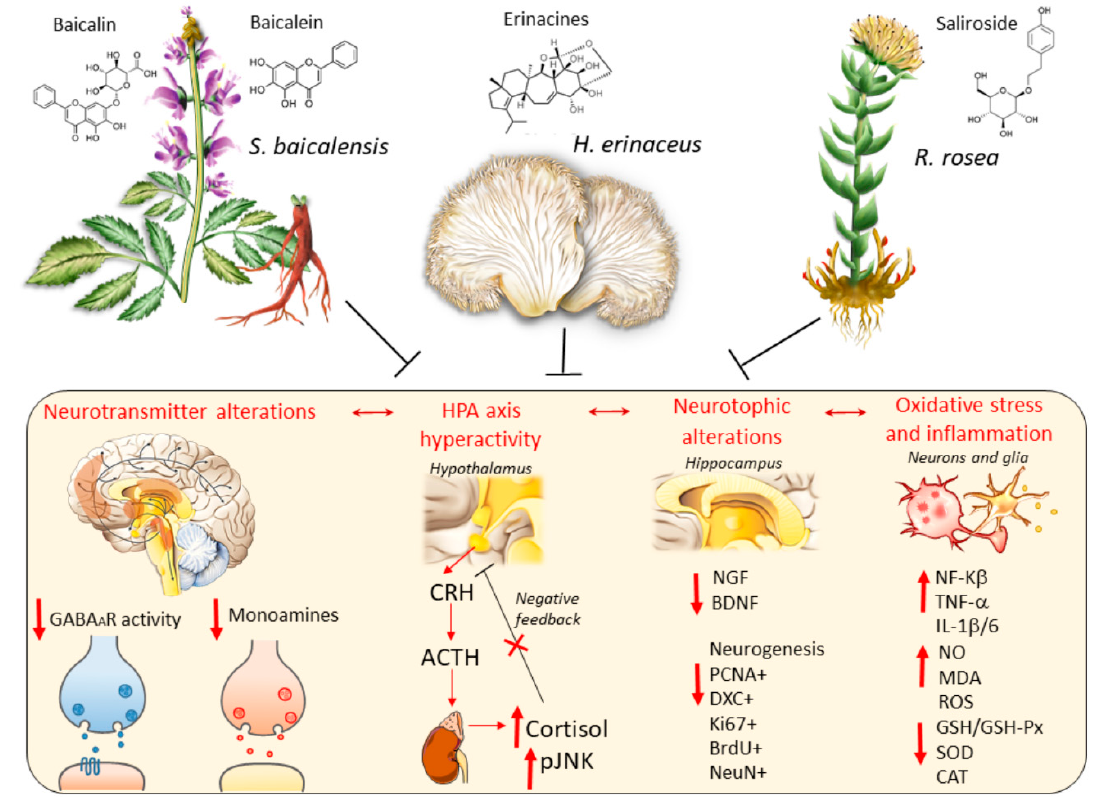
Figure 1. A general view on the mechanisms of action of S. baicalensis , H. herinaceum and R. rosea against the main biological pathways that are altered in depression and depressive-like behavior (yellowish box). Hypotheses on the neurobiology of depression and anxiety are largely based on dysregulations of (i) neurotransmitter systems, including GABA and GABA A receptors [8], as well as monoamines (dopamine, norepinephrine and serotonin) [9]; (ii) hypothalamic-pituitary-adrenal (HPA) axis consisting of an abnormal release of corticotropin-releasing factor (CRH), adrenocorticotropin (ACTH) secretion from the anterior pituitary, abnormal secretion of glucocorticoids (cortisol in humans and corticosterone in rodents), activation of phosphorylated c-Jun kinase (pJNK), and aberrant negative feedback HPA axis [9]. (iii) impaired neurotrophic mechanisms consisting of low expression of nerve growth factor (NGF) and brain-derived neurotrophic factor (BDNF), impaired neurogenesis and plasticity [9]; (iv) chronic oxidative stress and neuroinflammation [10]. Black T-shaped lines indicate inhibition. Red bold arrows indicate downregulation or hyperactivation. Red thin arrows indicate sequential molecular events.